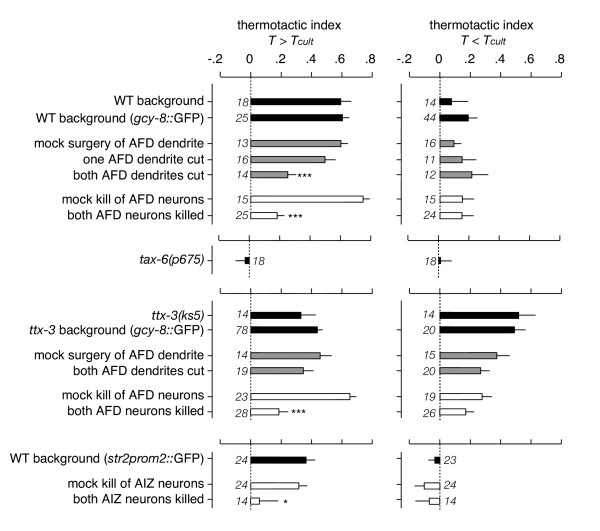
Effects of laser surgery on cryophilic bias. The amount of cryophilic bias exhibited by worms assayed above and below Tcult. In each panel, black bars correspond to experiments with worms that did not undergo surgery or surgical preparation, gray bars correspond to experiments in which AFD dendrites were severed, and white bars correspond to experiments in which neurons were killed. Mock control measurements represent worms that were prepared for surgery without undergoing laser irradiation. The values of the thermotactic index are means ± one standard error. The cases in which surgery significantly affects cryophilic bias in comparison to its respective mock control are indicated by asterisks (***, P < 0.0005; *, P < 0.05). All other cases are not distinguishable from their respective mock controls (P > 0.2). Significance was measured using a two-tailed Student's t-test. The number of worms tested in each measurement of cryophilic bias is noted next to each data bar.